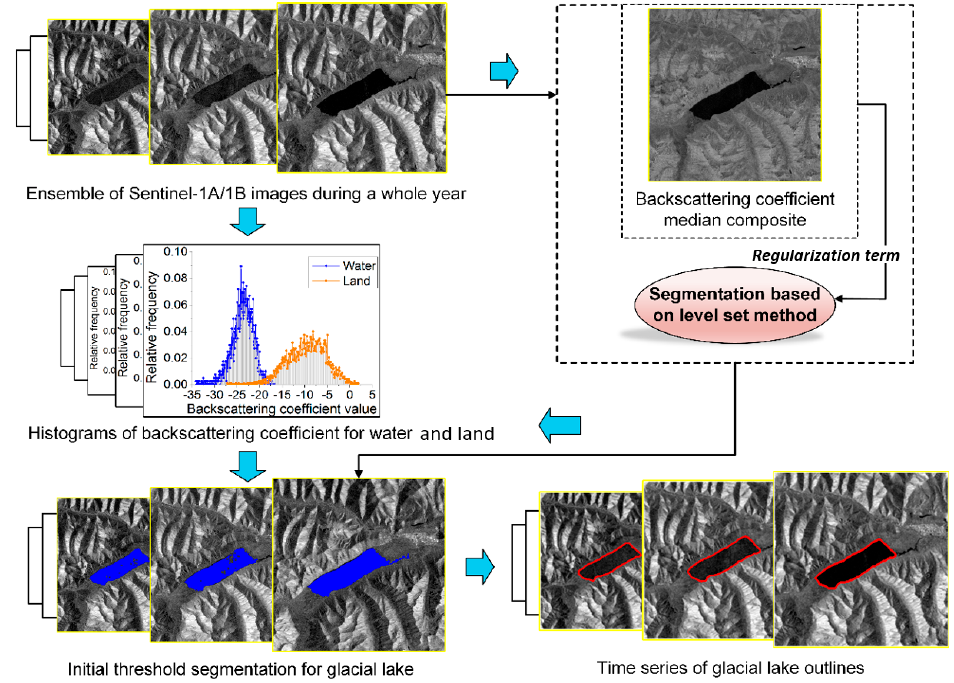
Figure 3. Conceptual graph of the basic steps in the process of mapping time series of glacial lakes.